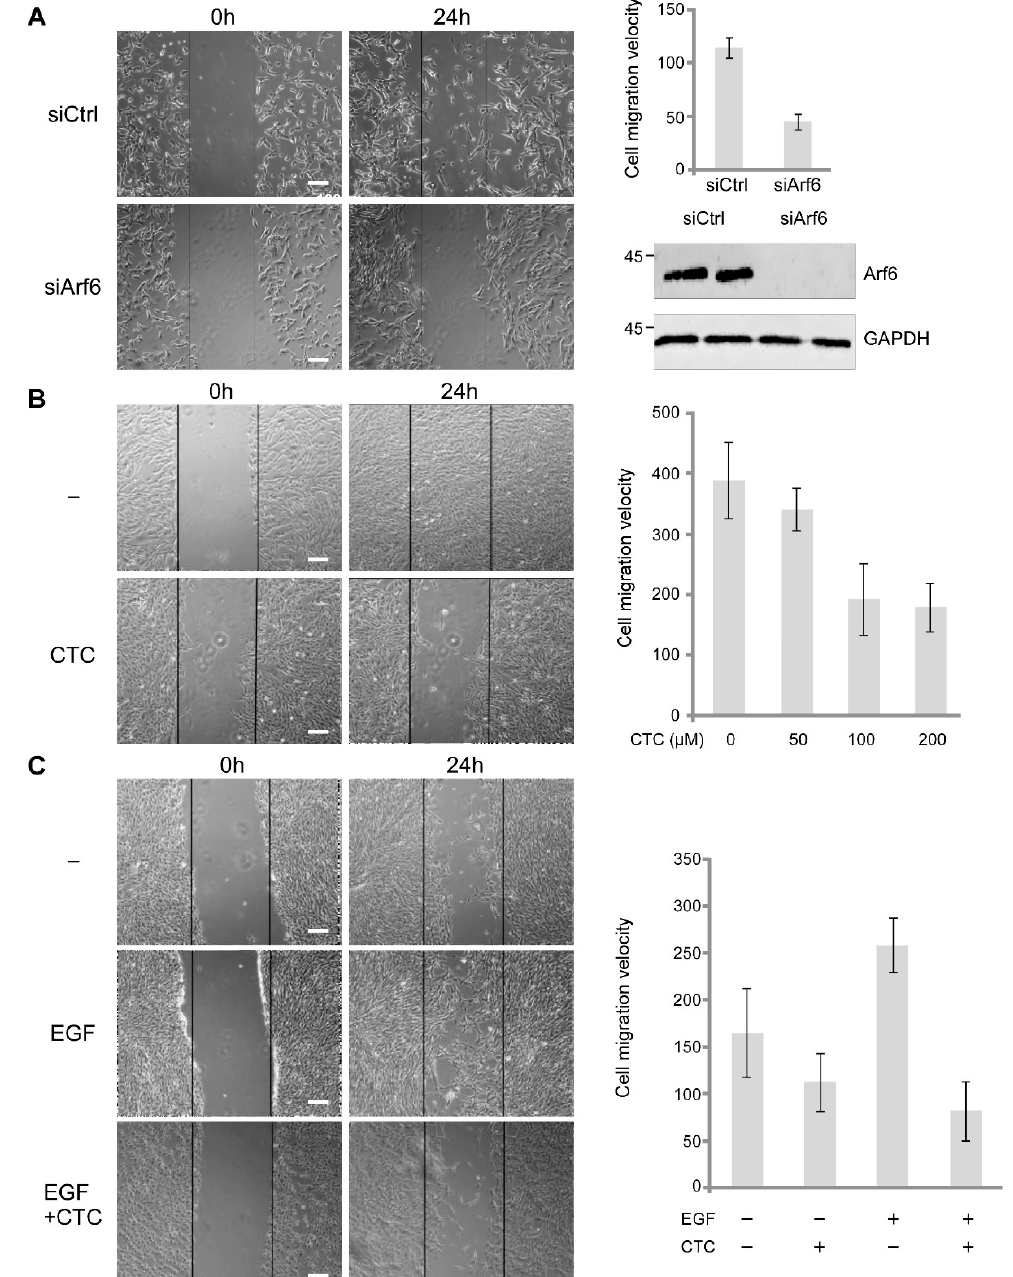
Figure 6. CTC blocks EGF-induced RPE cells migration. ( A ) Cells were transfected with non-relevant siRNA (siCtrl) or anti-Arf6 siRNA (siArf6) for 3 days and a wound healing experiment was performed. Speed of wound closure was determined using ImageJ software. ( B ) Anti-Arf6 western blot was performed to control siRNA inactivation. ( C ) As indicated, several CTC concentrations were used in the wound healing assay. ( D ) The CTC effect on wound healing was measured in the presence of EGF (50 ng/mL) stimulation.